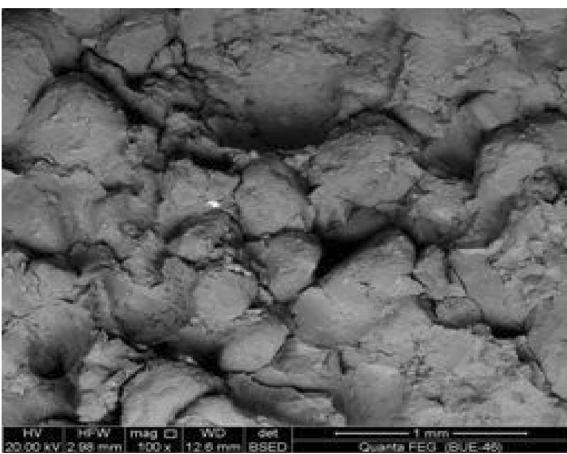
Fig. 5 SEM image ( 9 100)—big rounded gray quartz grains with clay between grain (Core 5-A)